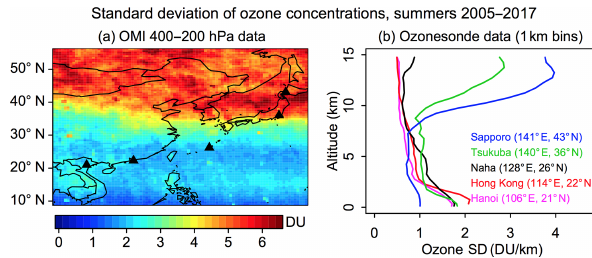
Figure 4. (a) Standard deviation of daily OMI 400–200hPa ozone in East Asia during the 2005–2017 summers. The triangles are the locations of ozonesonde sites with observations during this period. (b) Vertical profiles of daily ozone standard deviation in 1km bins (DUkm − 1 ) in the ozonesonde data for the 2005–2017